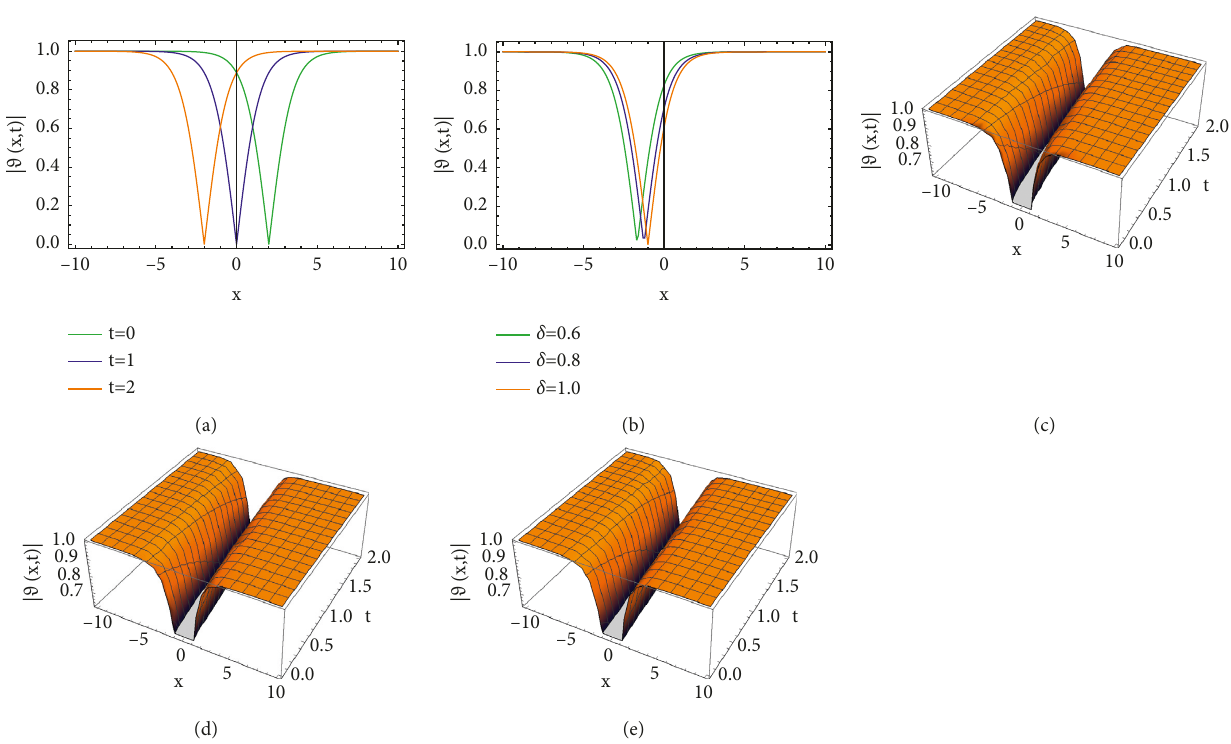
appears in equation (43). x,t ( )